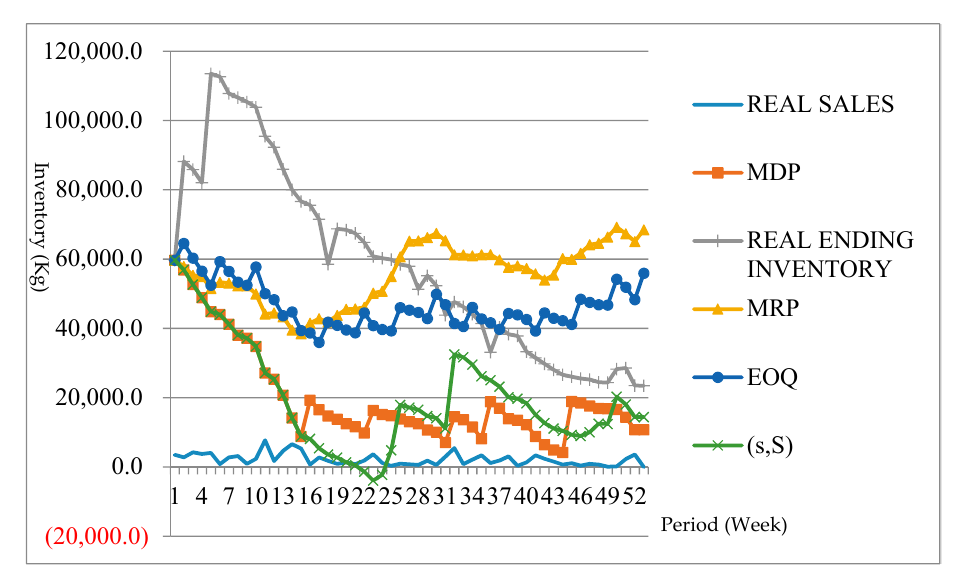
Figure 1. Inventory charts (period 113 to 164).